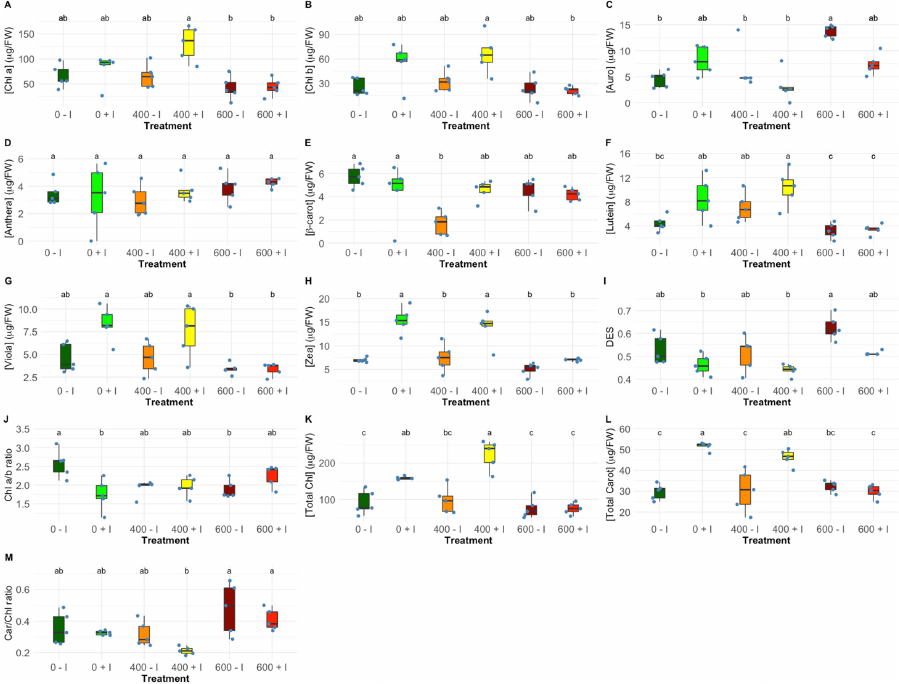
Figure 4. Leaves pigment relative concentrations ( μ g g − 1 FW), ( A ) chlorophyll a (Chl a), ( B ) chlorophyll b (Chl b), ( C ) auroxanthin (Auro), ( D ) antheraxanthin (Anthera), ( E ) β‐ carotenoids ( β‐ carot), ( F ) lutein, ( G ) violaxanthin (Viola) and ( H ) zeaxanthin (Zea), ( I ) de ‐ epoxidation state (DES), ( J ) chlorophyll a / b ratio (Chl a/b ratio), total ( K ) chlorophyll and ( L ) carotenoid ( μ g g − 1 FW), and ( M ) total carotenoid to total chlorophyll ratio (Car/Chl ratio) in non ‐ inoculated and inoculated Halimione portulacoides individuals (N = 5), along with the tested NaCl concentrations. Letters indicate significant differences between treatments at p < 0.05.